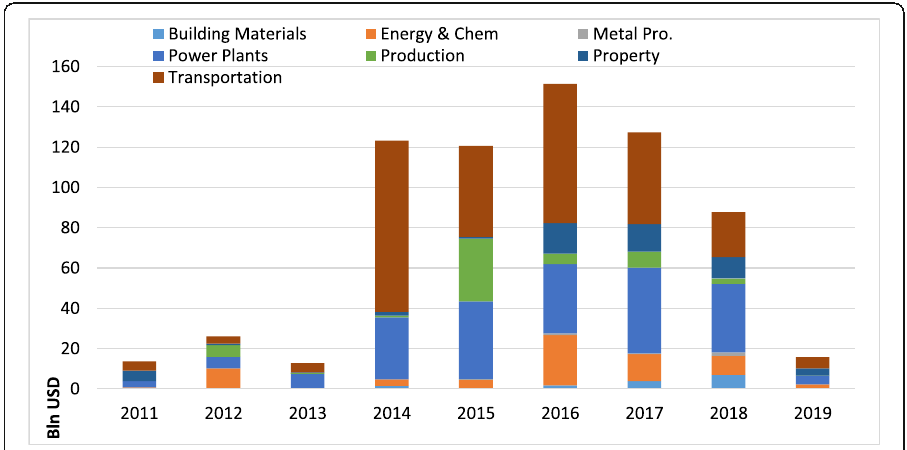
Fig. 2 Contracted projects (Source: Authors ’ elaboration from Clarkson-SIN data,